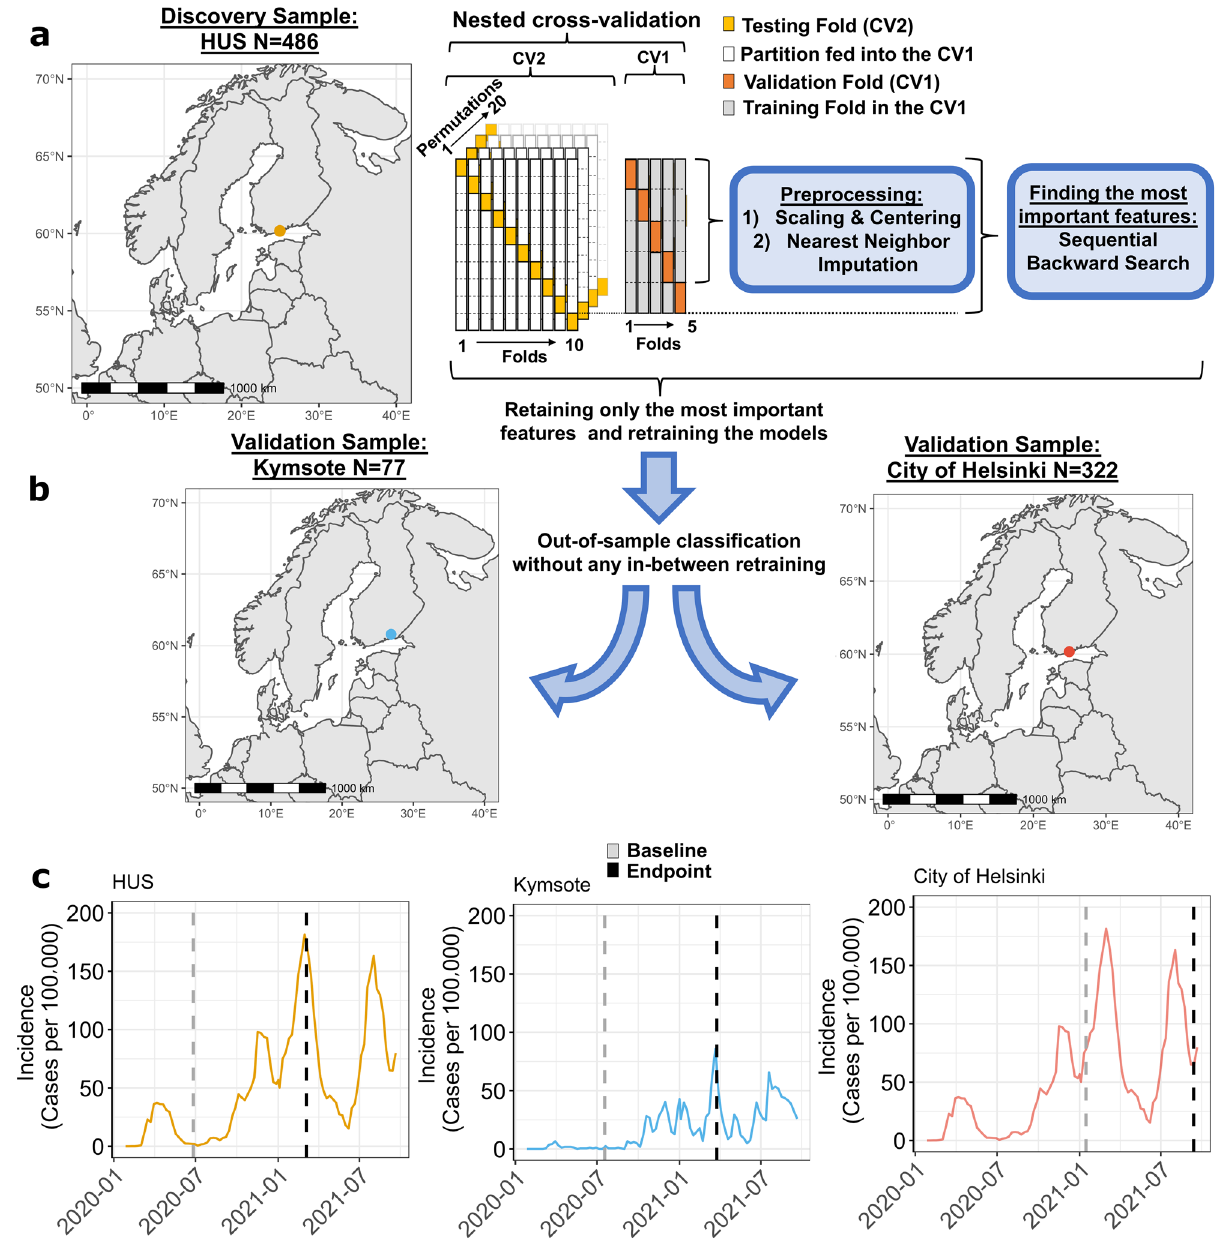
Figure 1. Flowchart depicting the analyses and samples of the present study. ( a ) Machine learning pipeline in the HUS discovery sample. ( b ) Condensed models (i.e., models trained on the most important variables) were applied to Kymsote and the City of Helsinki validation samples without any in-between retraining. ( c ) Incidence of COVID-19 in the district of each sample (data from https:// sampo. thl. fi/ pivot/ prod/ en/ epira po/ covid 19case/ fact_ epira po_ covid 19case). Dashed lines represent the follow-up period of each sample. The models were trained to predict resilience over the follow-up based on each sample’s baseline data (the gray dashed line). The endpoint is shown in black. Note that the incidence data for HUS and the City of Helsinki are identical since the HCWs of these datasets were working in the same area. Maps were created with "rnaturalearth" R package version